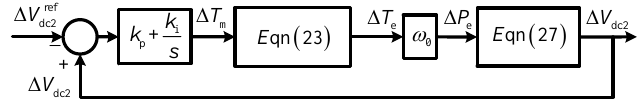
Figure 6. Small signal model of voltage control diagram of VSC2.